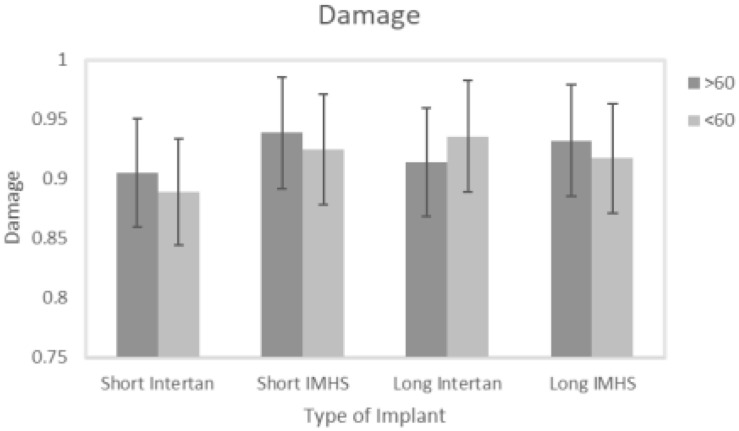
Damage versus age.